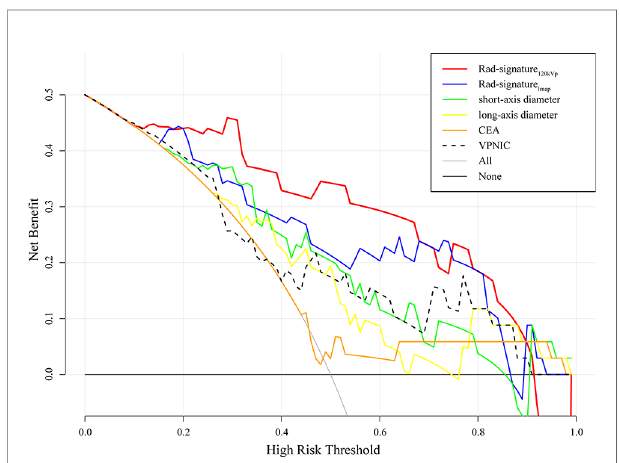
FIGURE 7 | Receiver operating characteristic (ROC) curve of 6 different signatures or indicators in the testing cohort. The 120kVp-like radiomics signature had the highest area under Curve (AUC). Only the curve of the DECT quantitative parameter with the highest AUC (VPNIC) was drawn to improve readability. VPNIC: venous phase normalized iodine concentration.